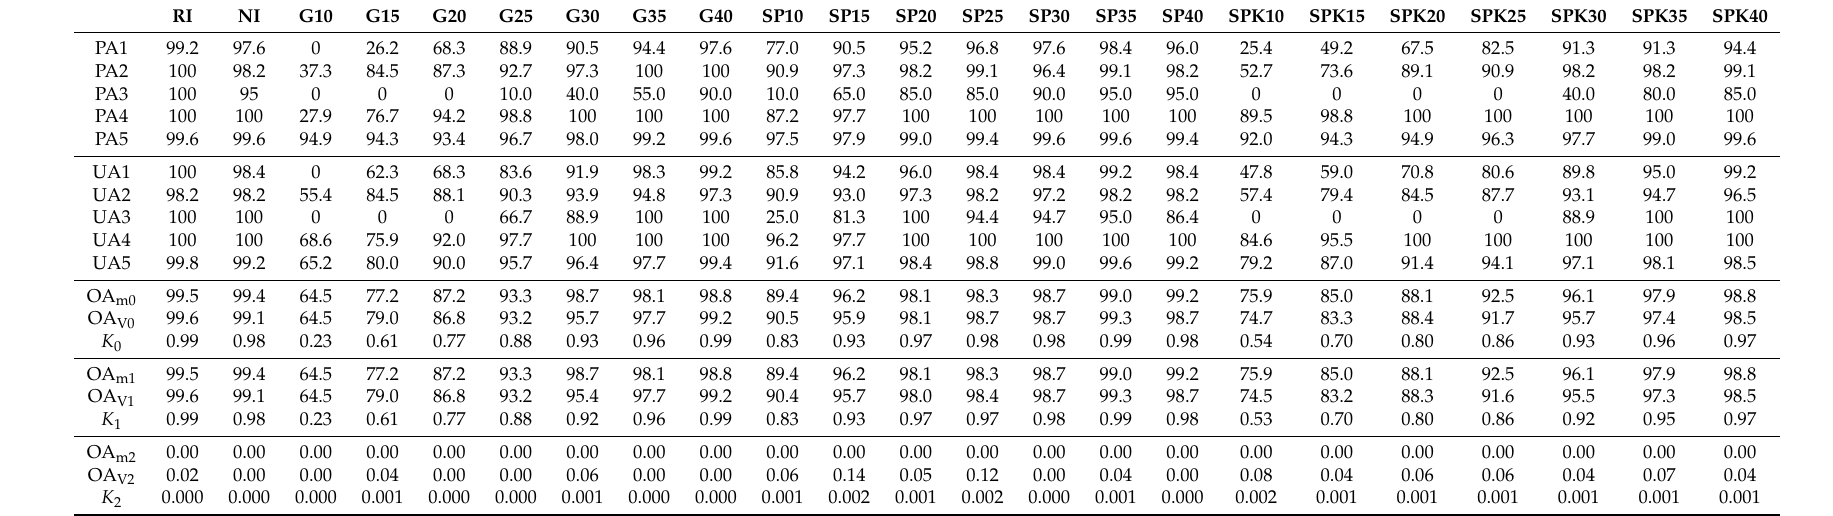
Table 4. Classification accuracies of the SVM